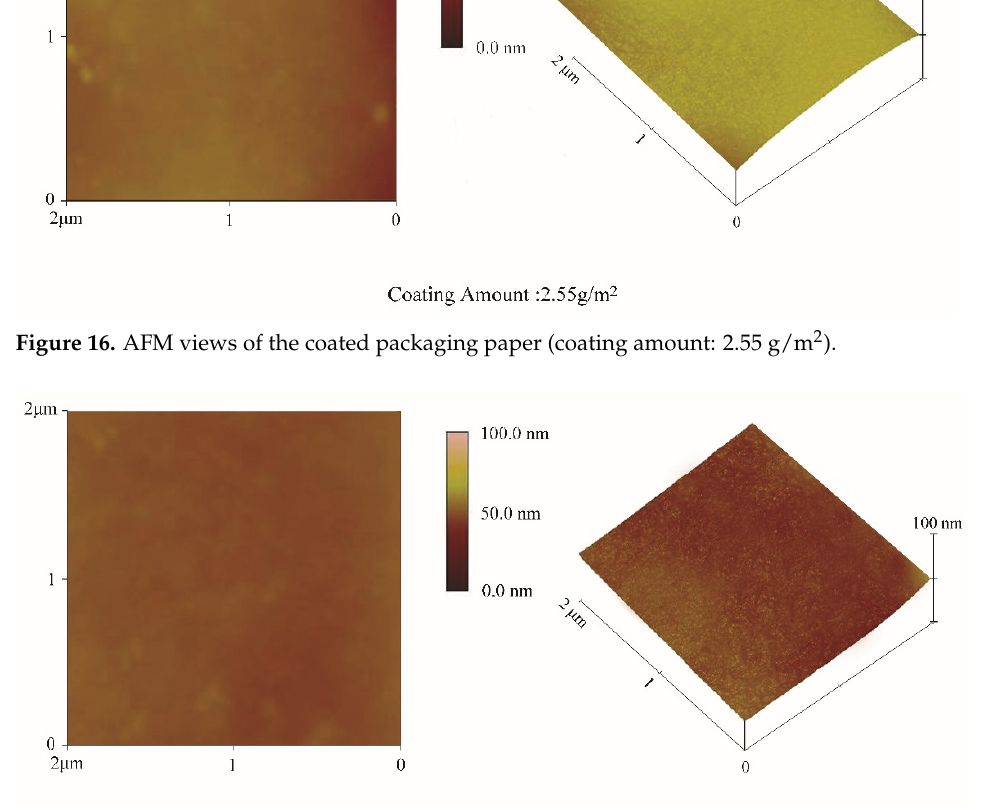
Figure 17. AFM views of the coated packaging paper (coating amount: 3.60 g/m 2 ).